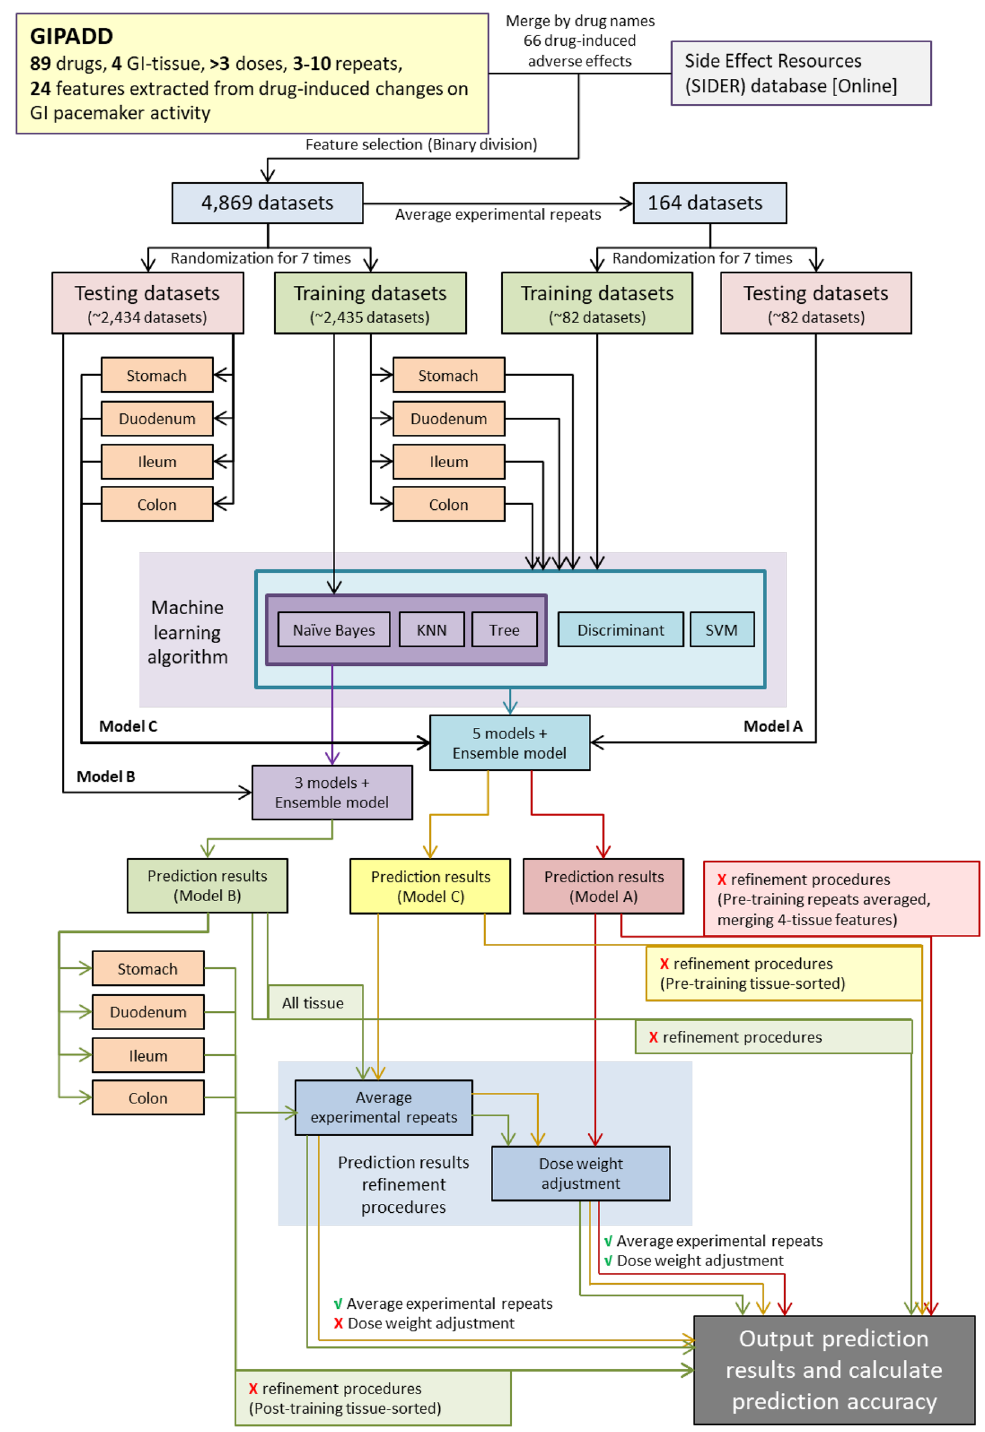
Figure 1. A flow chart showing the process from dataset preparation, to ML model training, to prediction result refinement for generating different types of ML